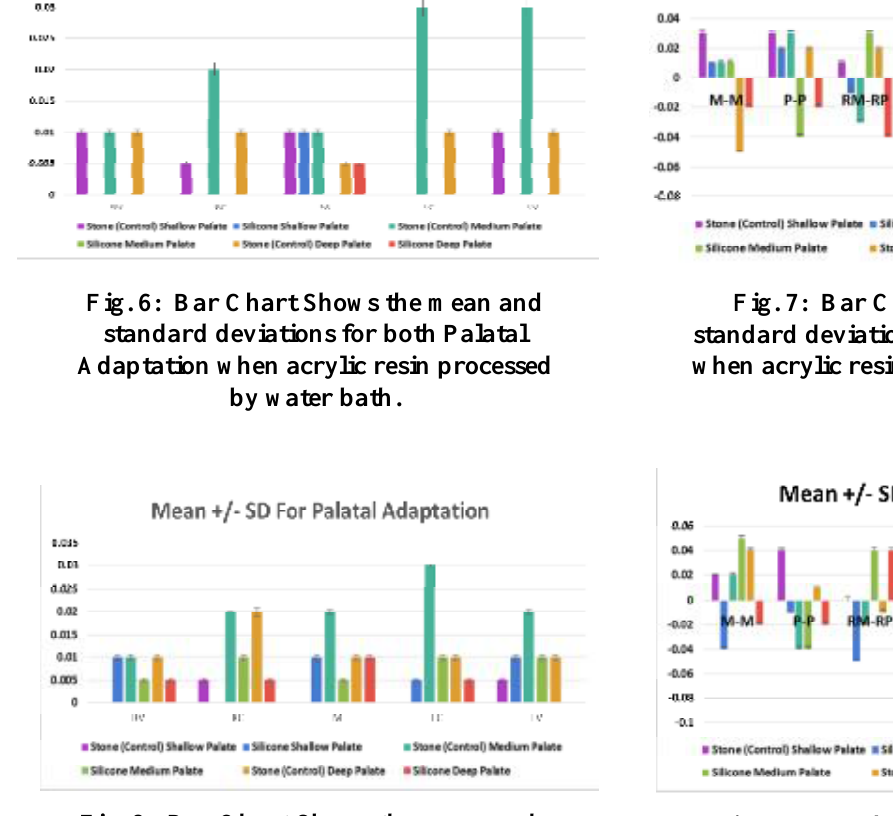
Fig. 9: Bar Chart Shows the mean and standard deviations for both teeth movements when acrylic resin processed by Slow autoclave